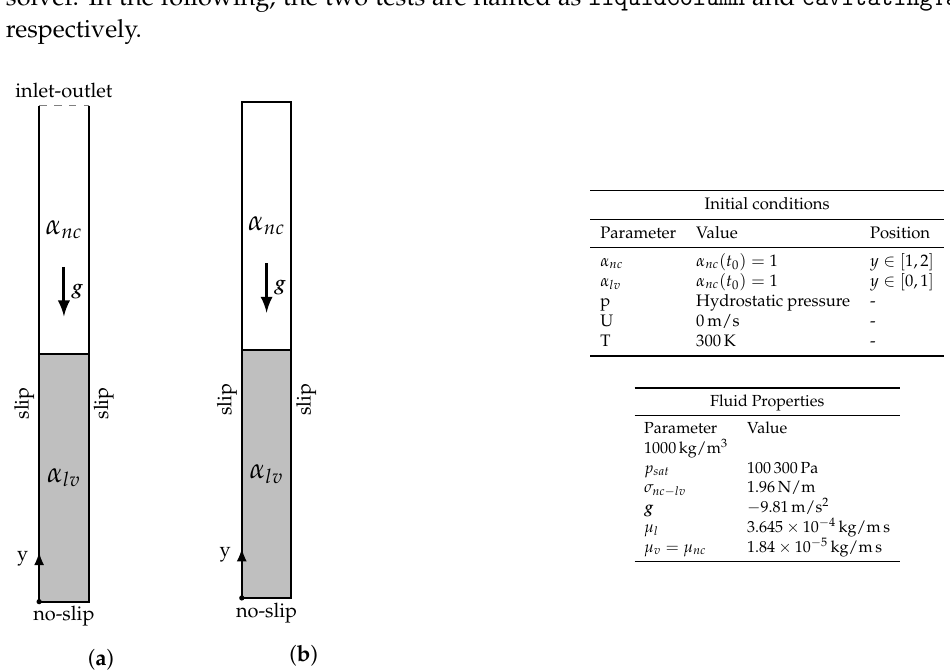
Figure 10. Test cases for solver verification with phase change, geometry, boundary and initial conditions. Geometry type: ( a ) open; ( b ) closed.